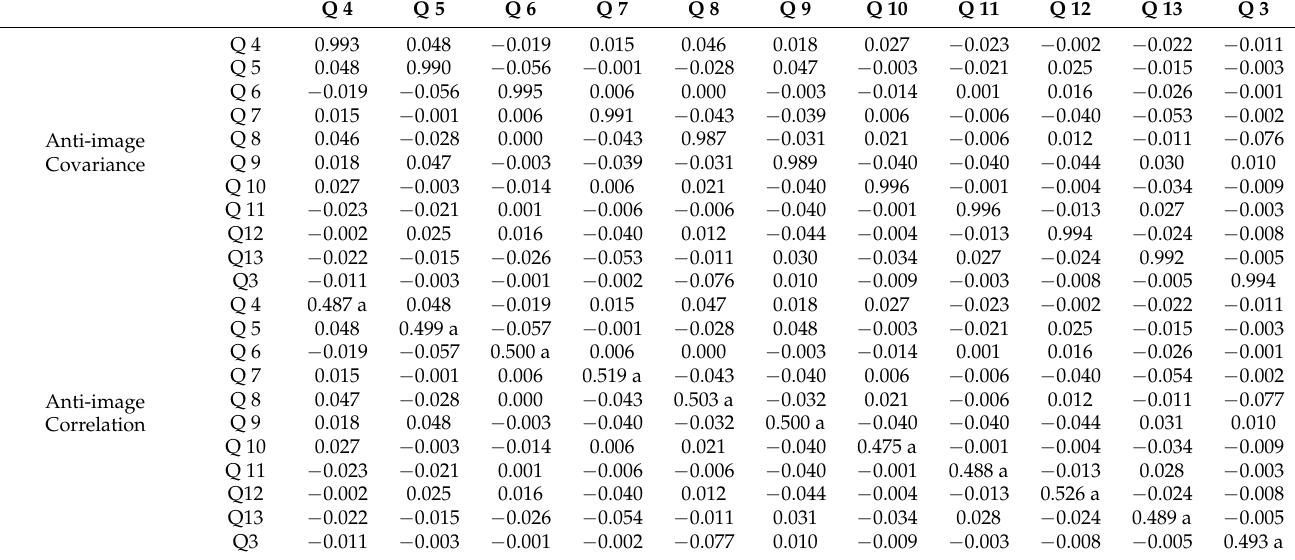
Table 8. Anti-image matrix that identifies the covariance and correlation values for each question.